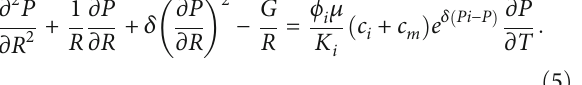
s in polluted area with